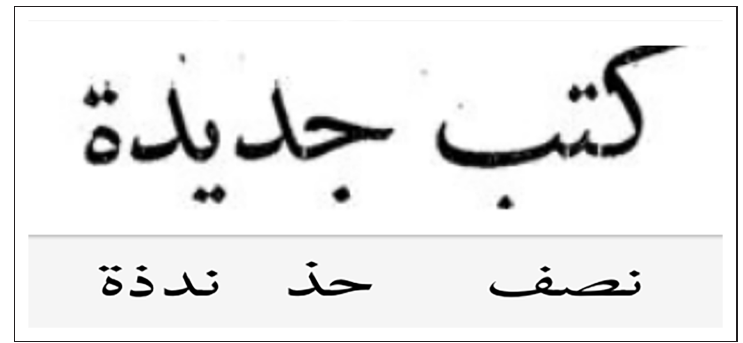
Figure 8: Bolded and enlarged text size header and poor transcription.